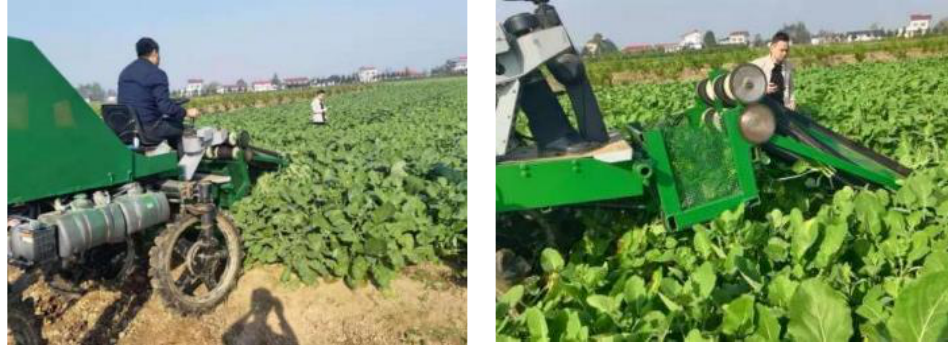
Figure 17. The field test.